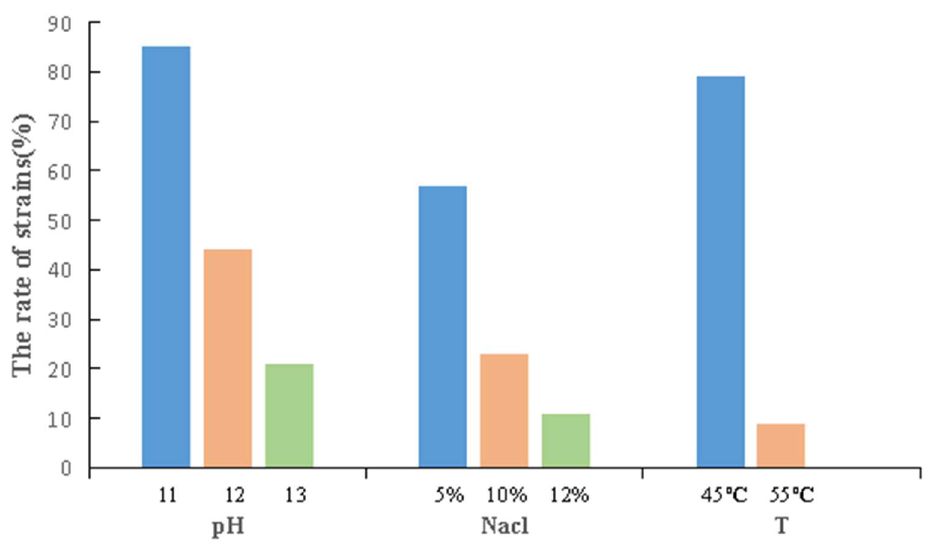
Figure 6. Resistance characteristics of actinobacteria.